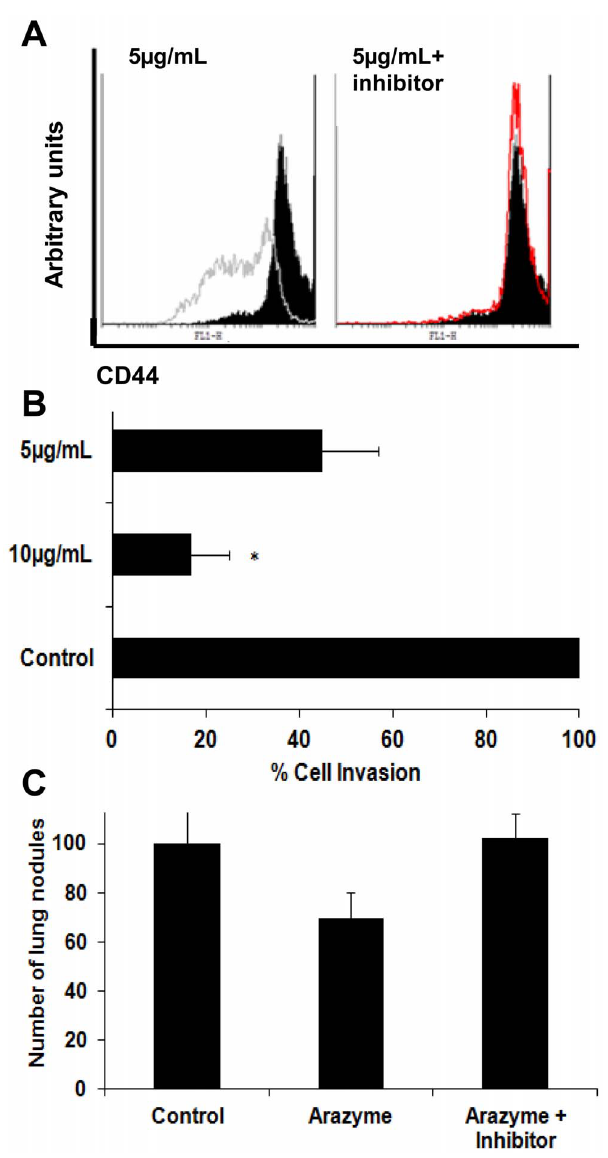
Figure 4. Metalloprotease activity of arazyme reduces CD44 expression on tumor cell surface, and reduces invitro and in vivo the invasion of B16F10-Nex2 melanoma cells. (A) B16F10- Nex2 cells were treated for 1 hour with 5 m g/mL of arazyme with or without ortho- phenantrolyne (2 mM) and were then incubated with FITC-conjugated anti-murine CD44 antibody. The full peak (black) represents CD44 expression in untreated tumor cells and the open area shows CD44 expression after treatment. (B) B16F10-Nex2 cells were previously incubated with arazyme (5 or 10 m g/mL for 1 hour) and the ability of these cells to invade matrigel was measured as described in materials and methods. Results of three independent experiments were grouped. (C) B16F10-Nex2 melanoma cells were previously incubated for 1 hour at 37 u C with 20 m g/mL of active arazyme, 2 mM ortho - phenantrolyne-inactivated arazyme or saline solution. C57Bl/6 mice (5 animals/group) were i.v. inoculated with 3 6 10 5 treated tumor cells and lung nodules were counted after 15 days.*, p #